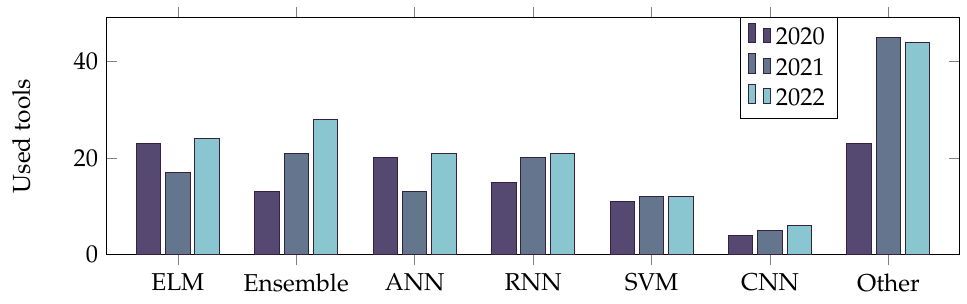
Figure 6. Top ML methods used in particular years.